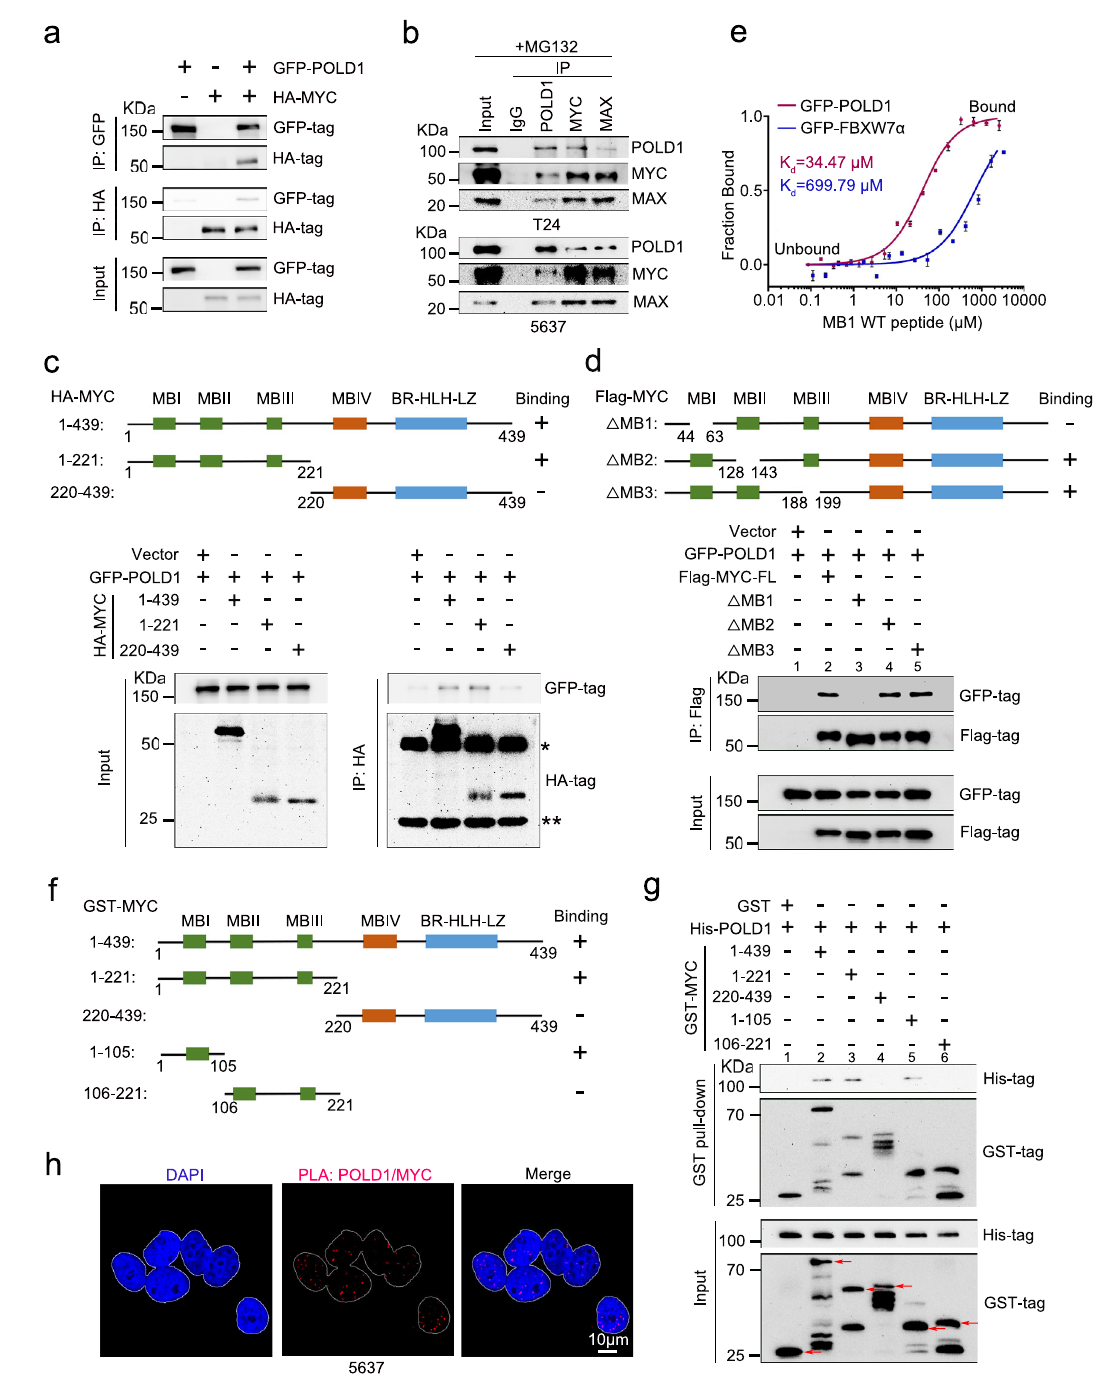
Fig. 5| POLD1 isadirect binding partnerof MYC. a Westernblot analysis of GFP- POLD1 and HA-MYC after GFP-IP or HA-IP in 293T cells. The input was 10% of the extractused for the IP. b Westernblot analysis ofPOLD1, MYC, and MAX after IgG, POLD1-IP,MYC-IP,orMAX-IPinT24(toppanel)and5637(bottompanel)cells.MAX was used as a positive control for MYC endogenous interaction. c Schematic dia- gram of various MYC truncations in the Co-IP assays (top panel). Western blot analysis of GFP-POLD1 and HA-MYC after HA-IP in 293T cells (bottom panel). d Schematic diagram of various MYC deletion mutations in POLD1 binding assays (top panel). Western blot analysis of GFP-POLD1 and Flag-MYC after Flag-IP in 293T cells (bottompanel). e MSTanalysis wasused to measurethe binding af fi nity of lysates of overexpressed GFP-POLD1 in 293T cells and the MYC-MB1 (WT) pep- tide (Graph shows mean±SD from three biologically independent experiments in each group). Here, GFP-FBXW7 α was used as a positive control. The centerline